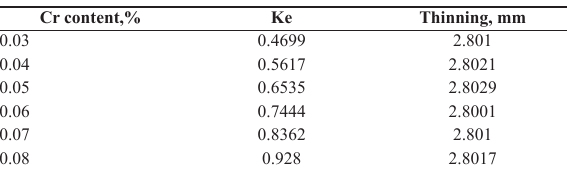
Table 3. Combinations of Cr content and Keller coefficient for steam pipelines.